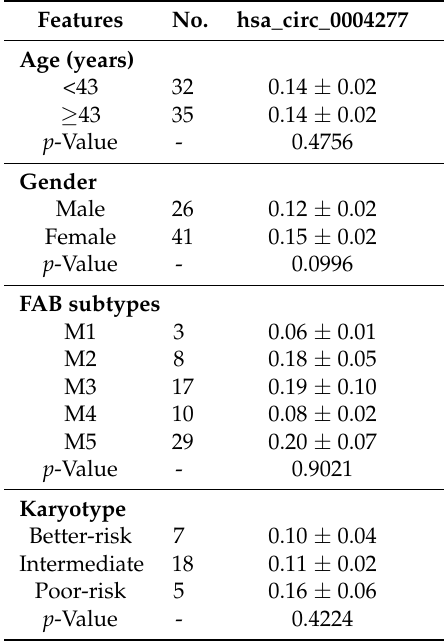
Table 3. Expression of hsa_circ_0004277 in different subgroups of newly diagnosed (ND) AML patients. Features